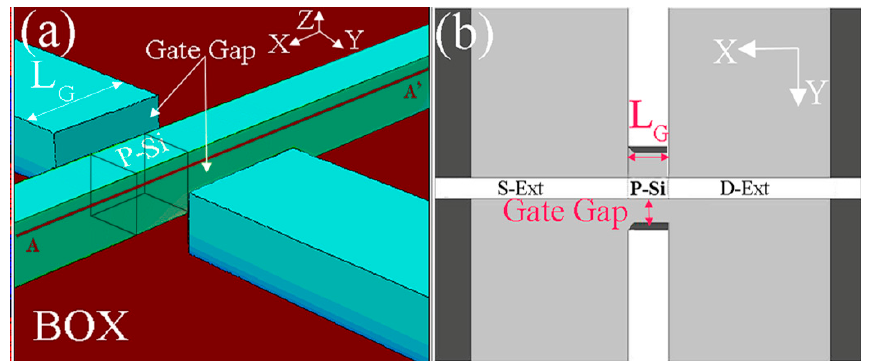
Figure 1. ( a ) Isotropic views and ( b ) top view of a nominal p-type double lateral gate junctionless transistors (DGJLT).